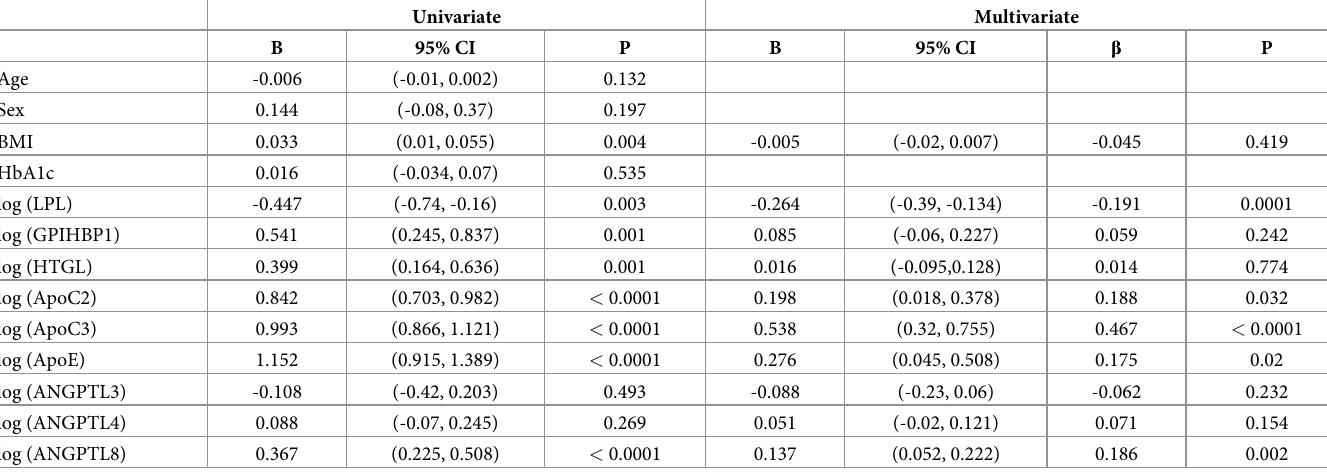
Table 5. Univariate and multivariate linear regression analyses of plasma TG levels and factors affecting TGs.